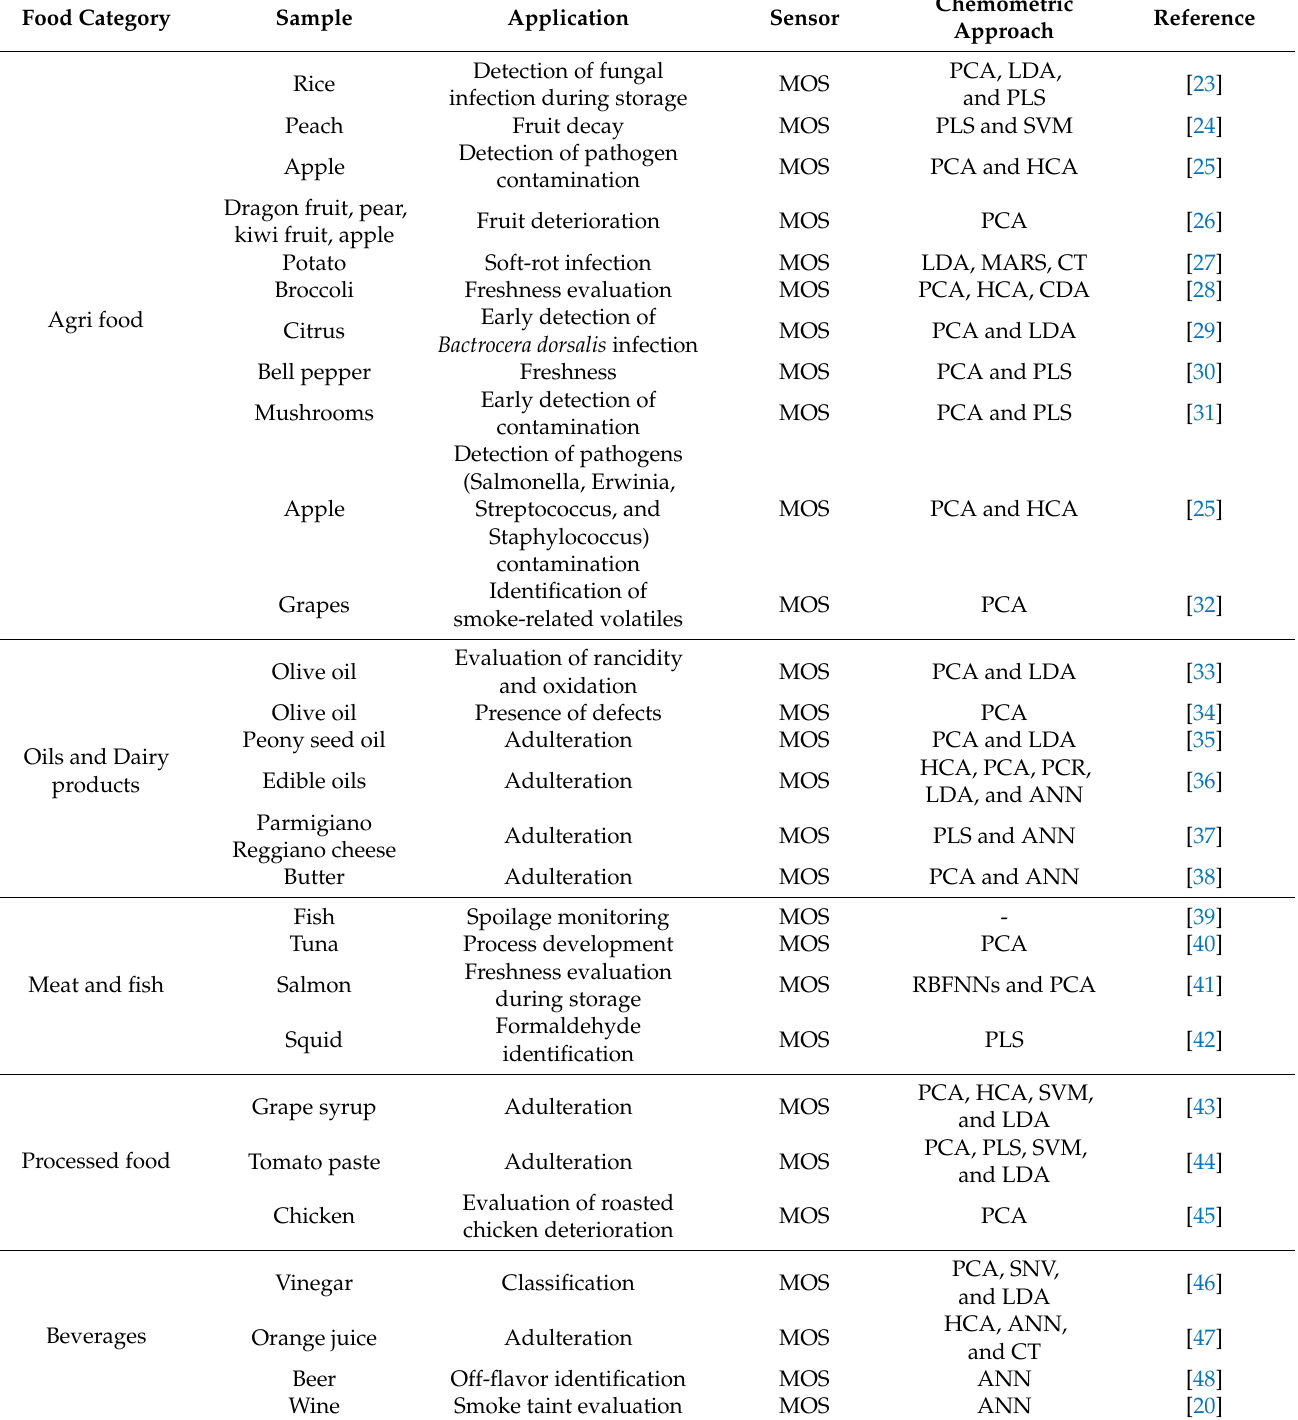
Table 1. Examples of E-Nose application for Food Analysis. MOS: metal-oxide semiconductors. ANN: artificial neural network; CDA: Critical discourse analysis; CT classification and regression tree; HCA: hierarchical cluster analysis; LDA: linear discriminant analysis; MARS: multivariate